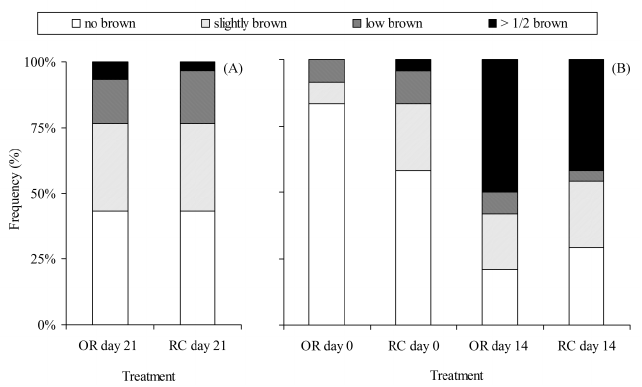
Fig. 2: Effects of rain cover on frequency of classes of stem browning (SB) in ‘Adriana’ and ‘Noire de Meched’ cherries after harvest and stor - age. (A), ‘Adriana’; (B), ‘Noire de Meched’. Each column repre - sents 30 cherries. OR, Orchard Uncovered; RC, Rain Covered Or - chard. SB classes: no brown, slightly brown (up to ¼ of stem length brownish), low brown (up to ½ of stem length brownish), brown (more than ½ of stem length brownish). Data were analyzed by c 2 tests. In A, when data were divided into three classes (no brown, slightly brown, and low brown + brown), P > 0.05. In B, due to small numbers in some classes, data were divided into two classes (no brown and all the rest) and showed P < 0.001. Partial comparisons between OR day 0 and OR day 14, and between RC day 0 and RC day 14 showed the significant storage effect ( P < 0.001 and P < 0.05, respectively), while the covering effect after 14 d storage (OR day 14 and RC day 14) was not significant ( P >